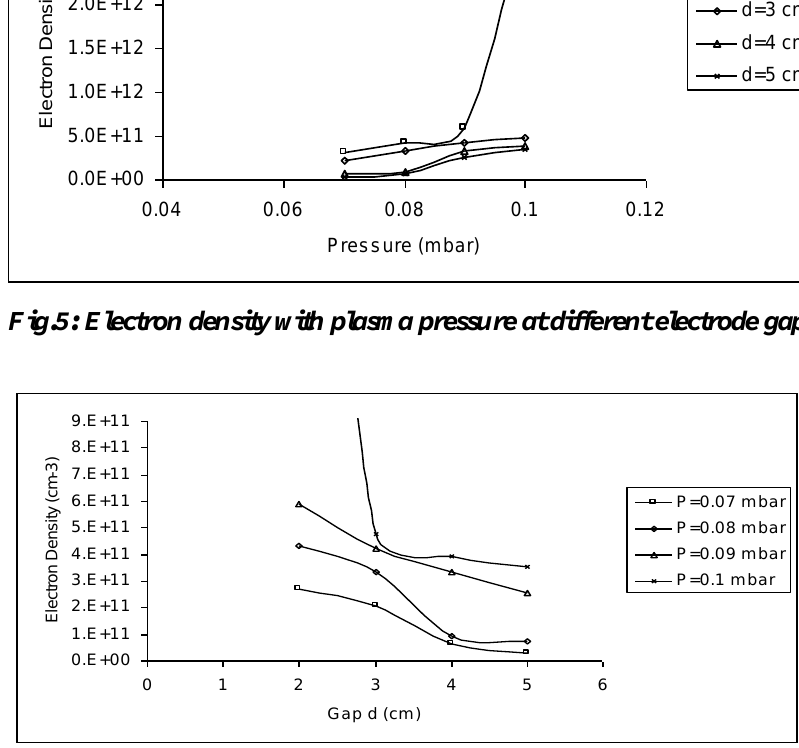
Fig.6: Electron density with electrode gap at different plasma pressure.